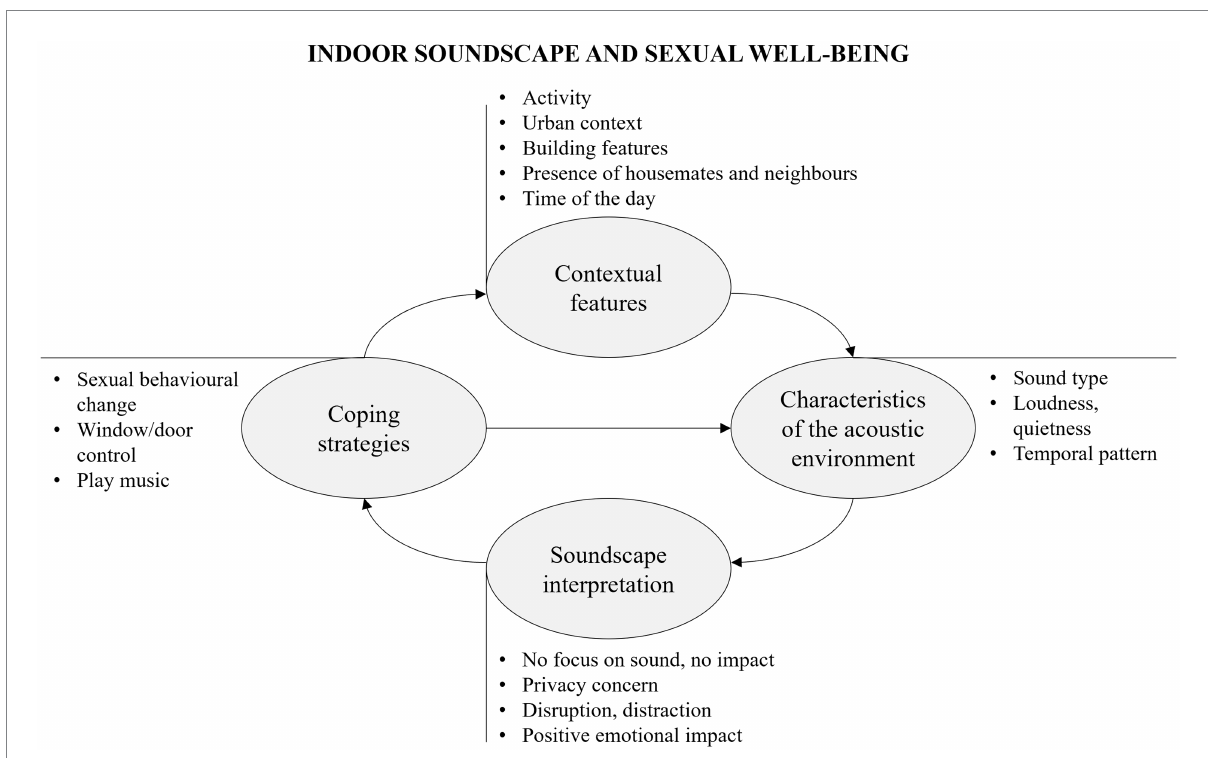
FIGURE 4 Thematic map on the relationship between indoor soundscape and home workout showing themes (within rounded boxes) and sub-themes, together with their causal interconnections.